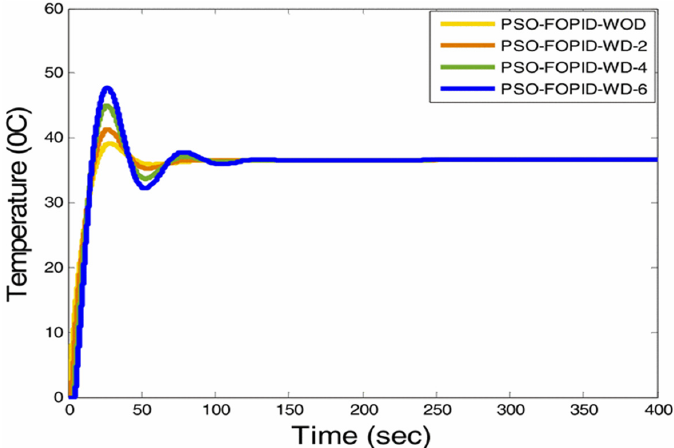
Table 5. Comparison of FOPID and PID performance in terms of different time specifications.